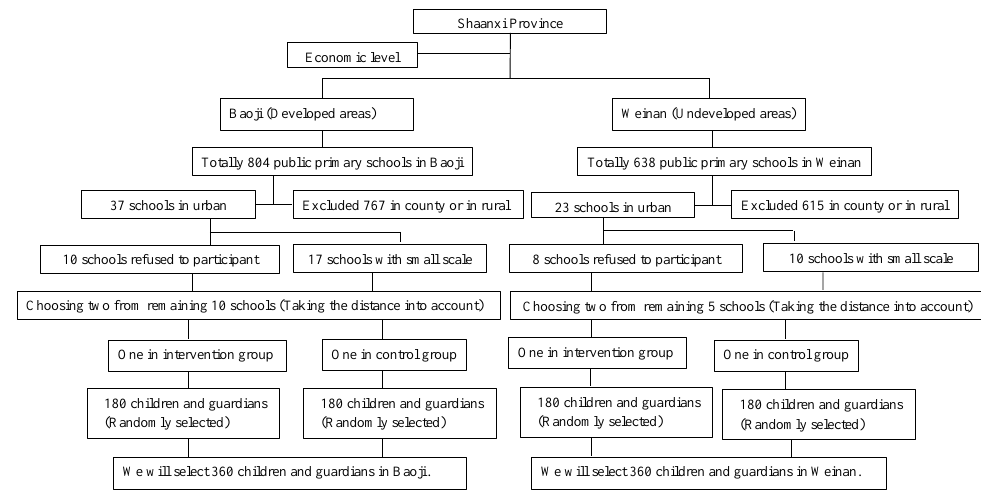
Figure 1. The sampling